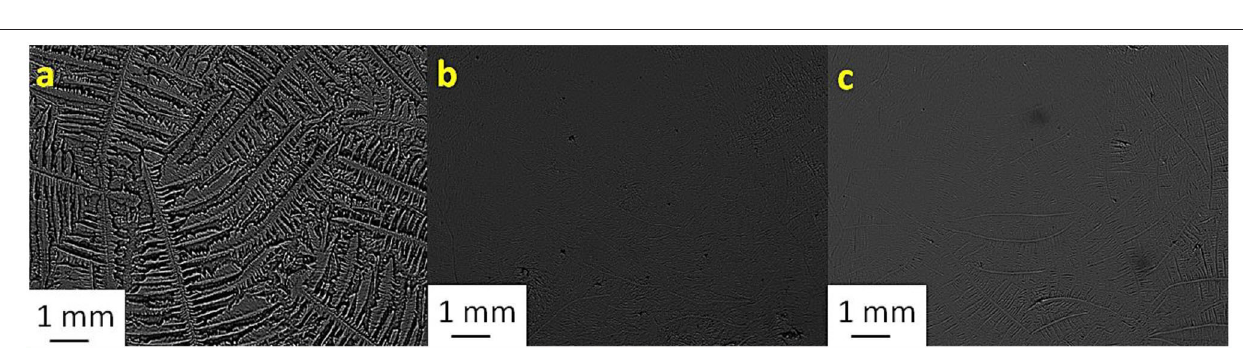
FIGURE 6 | Tear ferning patterns of (a) S6, (b) S6:CaCl 2 (1:8), and (c) S6:MgCl 2 .6H 2 O (1:10). S6, sixth sheep tear